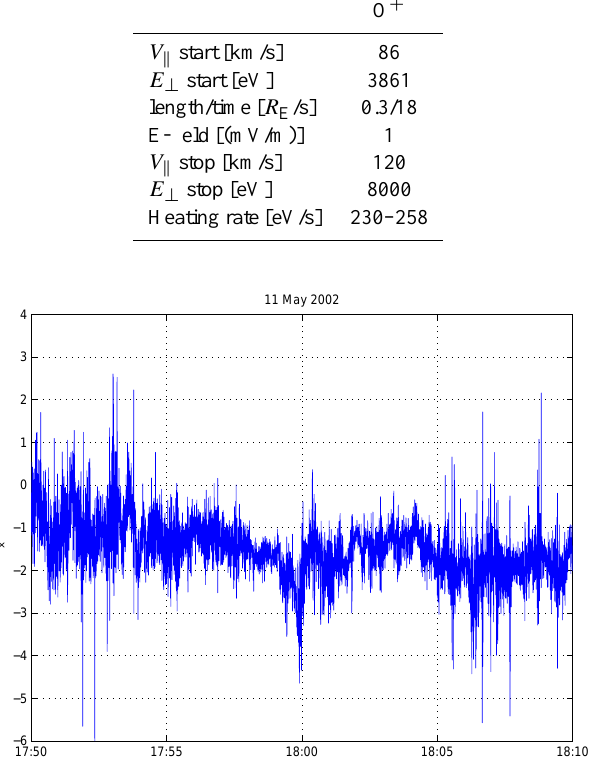
Fig. 4. The time series of the wave electric